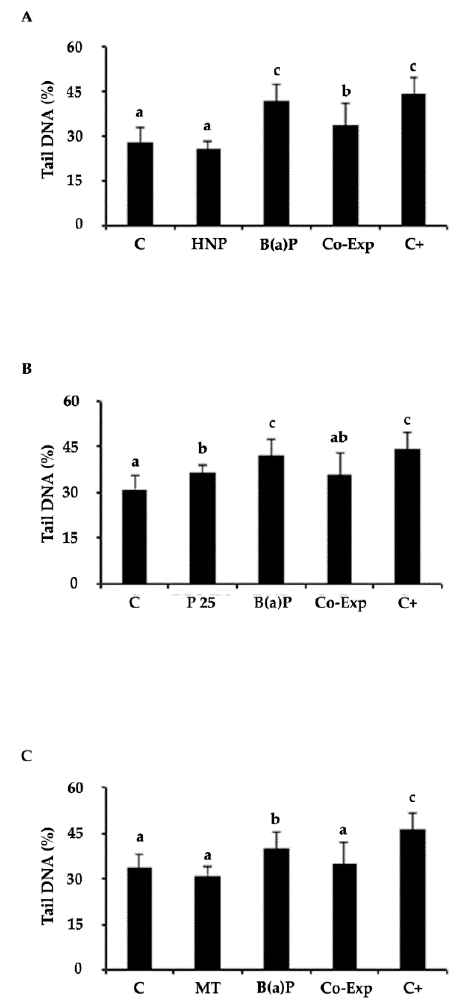
Figure 3. DNA primary damage (% tail DNA) in gill cells of M. galloprovincialis after exposure to the following experimental groups: C = control (ASW); HNP = 10 μ g/mL Hydrophilic CB-derived nanoparticles; P25 = 50 μ g/mL Aeroxide ® TiO 2 P25; MT = 50 μ g/mL Mesoporus titania; B(a)P = 2 μ g/mL Benzo(a)Pyrene and NPs, in co-exposure with B(a)P. ( A ) Co-exp: B(a)P and HNP. ( B ) Co- exp: B(a)P and P25. ( C ) Co-exp: B(a)P and MT. C+ positive control (H 2 O 2 100 μ M). Values are mean ± SD. Different letters indicate significant difference between the groups (Multiple Range Test, MRT p < 0.05, n = 9 for each experimental group).